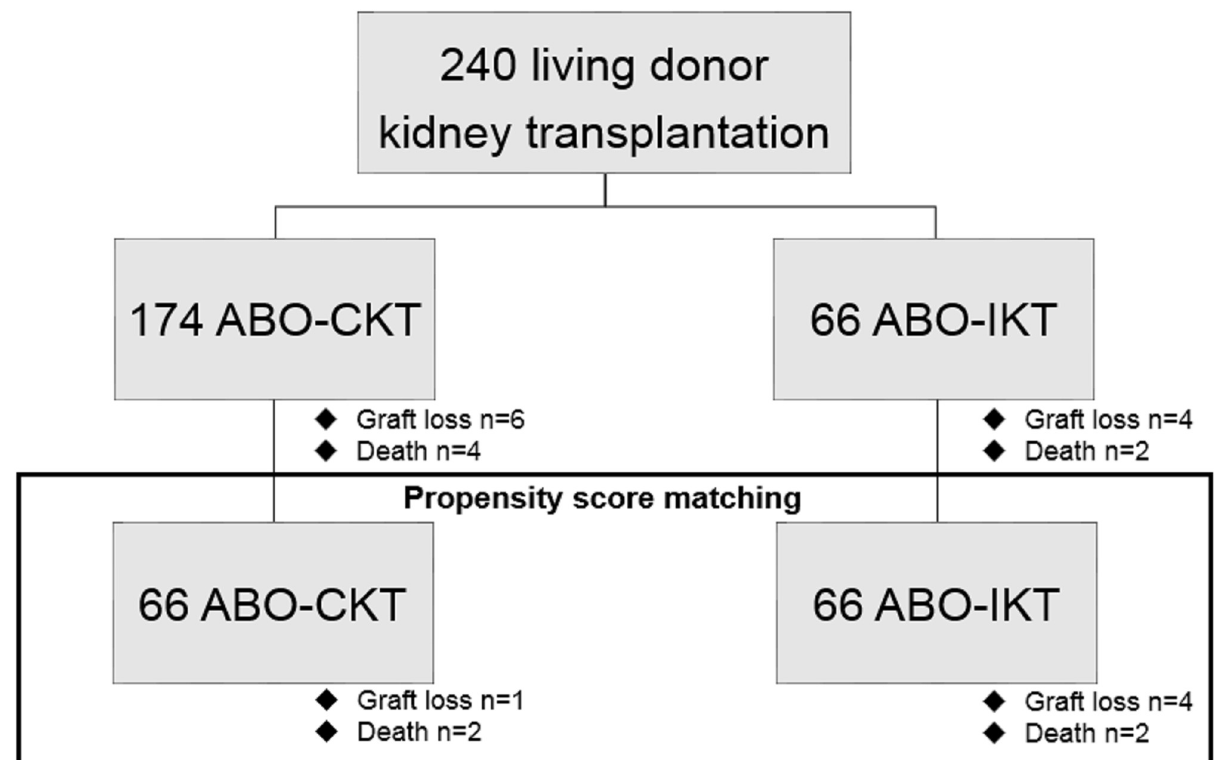
Fig 1. Defining the study population. Propensity score matching generated a matched cohort composed of 132 patients, 66 in each group. ABO-CKT; ABO-compatible kidney transplantation, ABO-IKT; ABO-incompatible kidney transplantation.